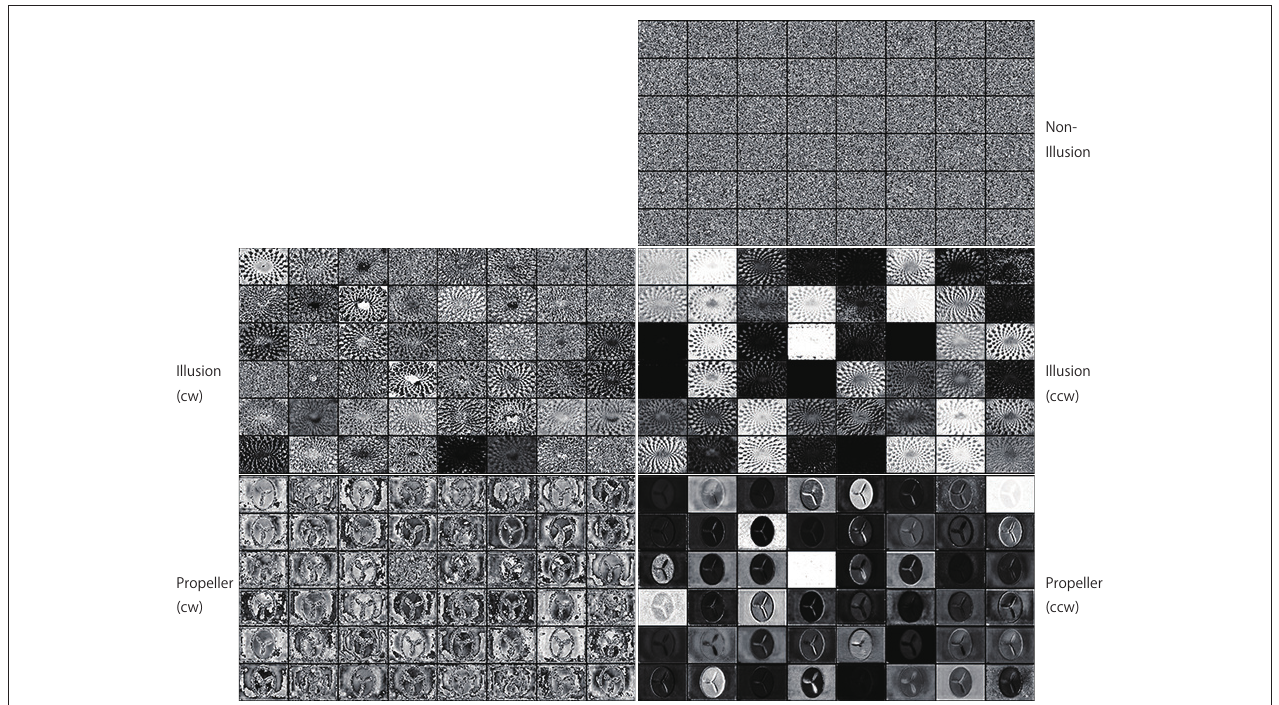
FIGURE 12 | Activation patterns of the hidden units of DNNs can be visualized (an upper layer). Samples of the activation patterns of receptive fields in an upper convolution LSTM layer are presented (R-Layer1/ConvLSTM/Variable_1_48_60_80_float32_30, refer to image data numbers of TensorBoard). A network trained with 500K video frames was used for prediction. Twenty consecutive images were input to the trained networks, and visualization was performed by TensorBoard. In this layer, there are 48 channels with a 60 (width) × 80 (height) pixel image. Note that noisy random patterns are specifically observed in “Non-Illusion,” and that a different pattern appears between the cw and ccw